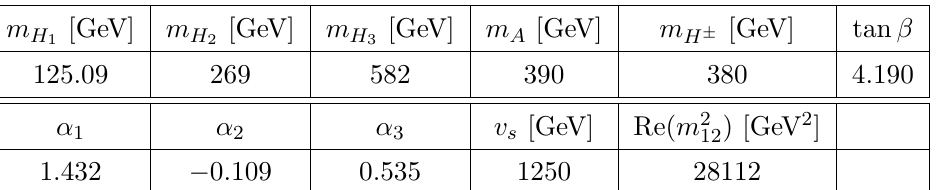
Table 23 . SMEFTBP2=BP6 : N2HDM-I input parameters.